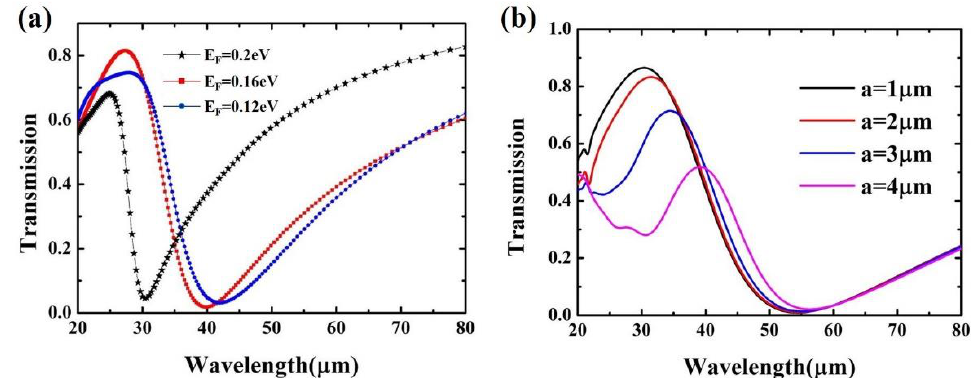
Figure 3. ( a ) Simulated amplitude transmission spectra of the structure with Fermi level changes from 0.12 eV to 0.2 eV. ( b ) Transmission spectra of the BP bowtie coupled with Au ring structure as a function of the side length of the bowtie BP. The side length ranges from 1 μm to 4μm. To illustrate the influence of the geometrical parameters of the Au ring on Fano resonance, the transmission spectra of the bowtie BP coupled with the Au ring structure by varying the inner and outer radius are demonstrated in Figure 4a. A very clear Fano resonance line appears in the transmission spectrum. Unlike the Lorentz line, the Fano resonance spectrum is asymmetric. The slope of the left shoulder of the resonance peak is not the same as the right, which is a typical Fano line with a maximum and a minimum. As the inner radius and outer radius increase, the wavelength of the resonance peak redshifts, and the amplitude of the transmission peak becomes larger. Because the wavelength of the Fano resonance peak will be determined by the diameter of the ring, expressed as [46]: